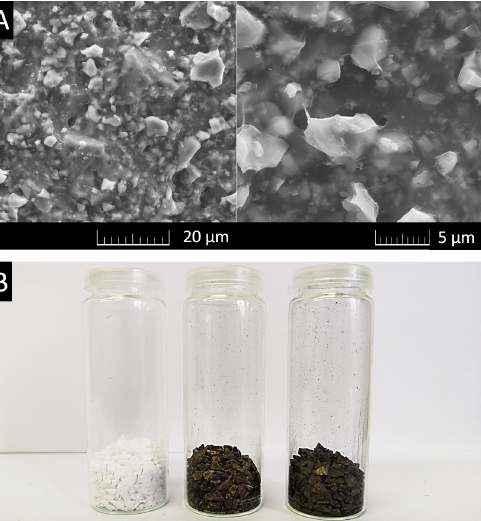
Figure 2. ( A ) SEM images of alumina grains coated with graphene oxide in two magnitudes and ( B ) uncoated grains ( left ), coated grains ( middle ) and treated grains ( right